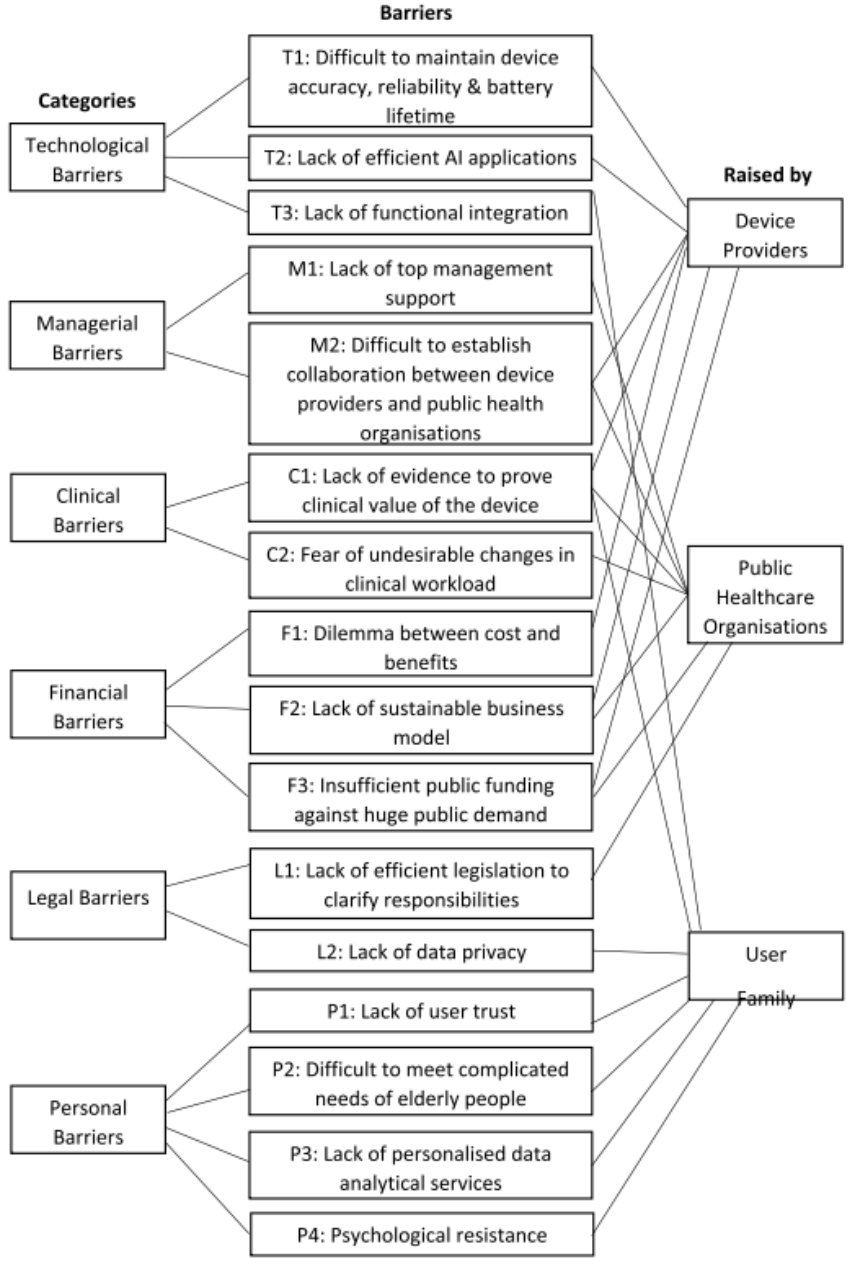
Figure 7. Barriers or challenges for AI smart wearables (Xing et al., 2021 [66]).